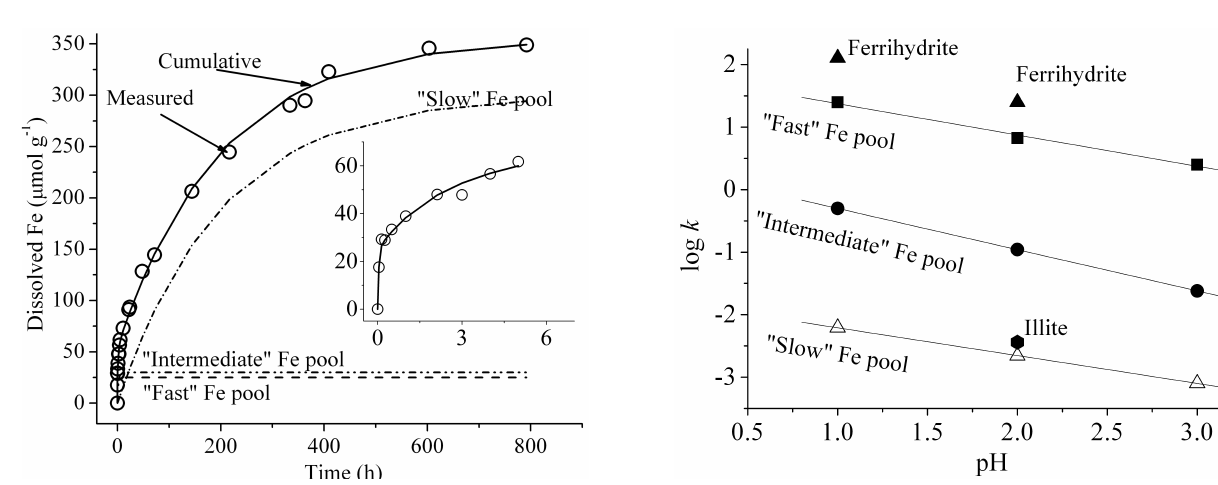
Fig. 6. Rate constant k (h − 1 ) for the three acid extractable pools as a function of pH. Solid lines represent linear regression for each of the three acid-extractable Fe